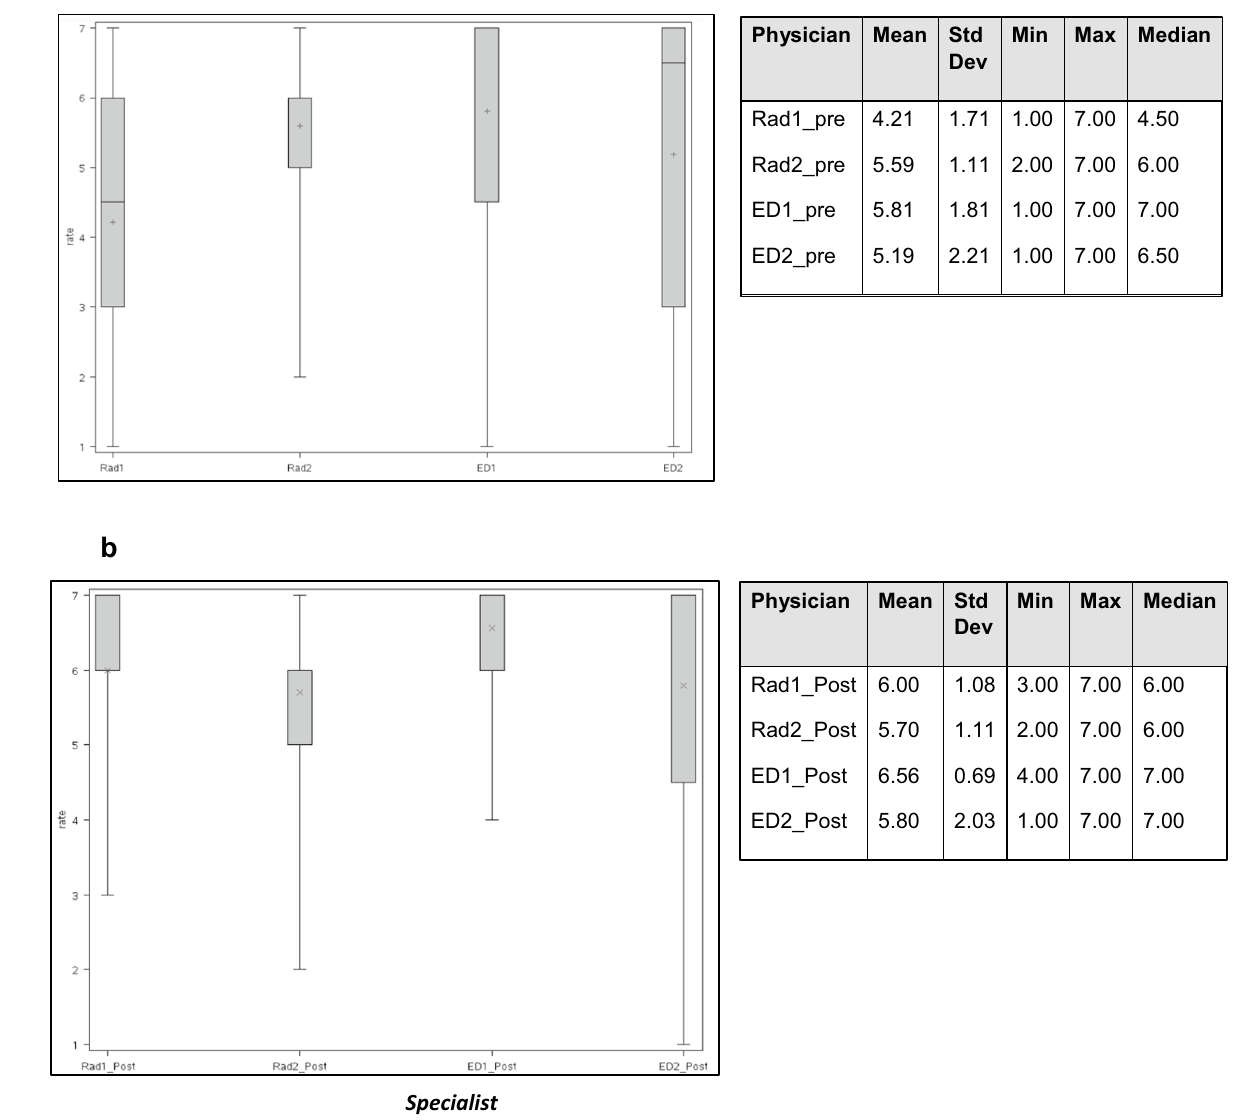
Fig. 1 A box plot comparing the ratings of the four physicians prior to ESR iGuide use ( a ) and after ESR iGuide consultation ( b ). Rad1—Radiologist 1, Rad2—Radiologist 2, ED1—Emergency Department Physician 1, ED2—Emergency Department Physician